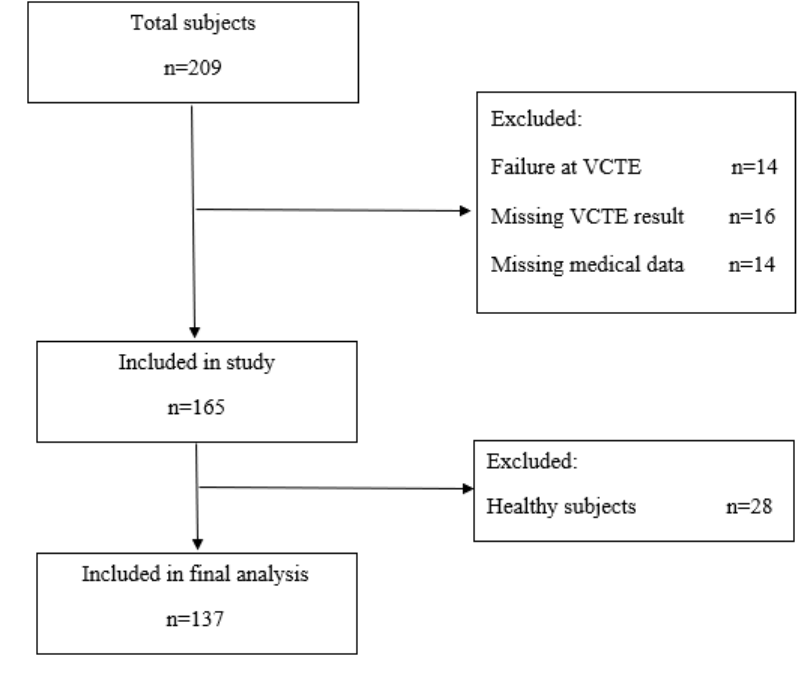
Figure 3. Study flow chart diagram. Table 1. Patient demographics and biochemical tests.